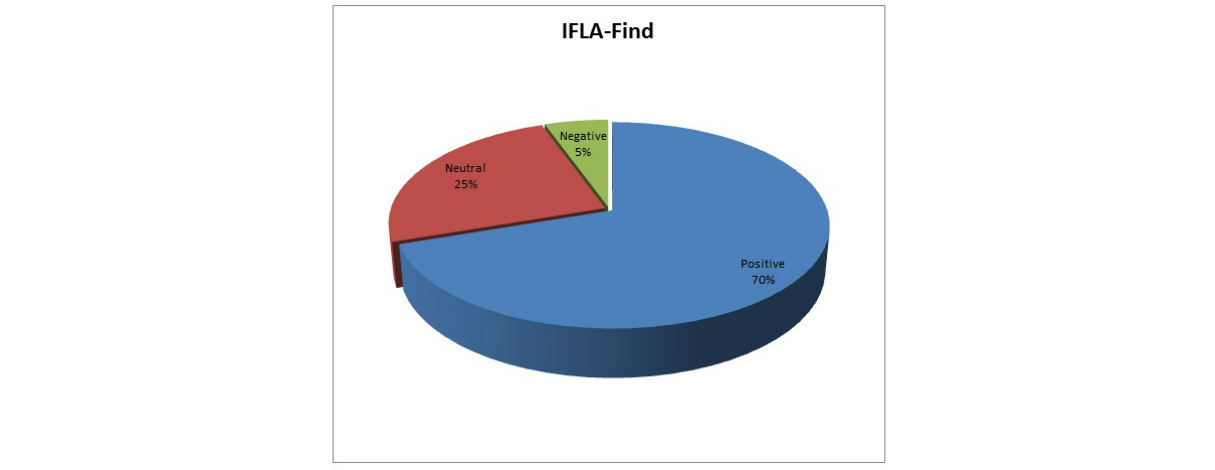
Figure 5. Users' responses mapped to the IFLA-Find